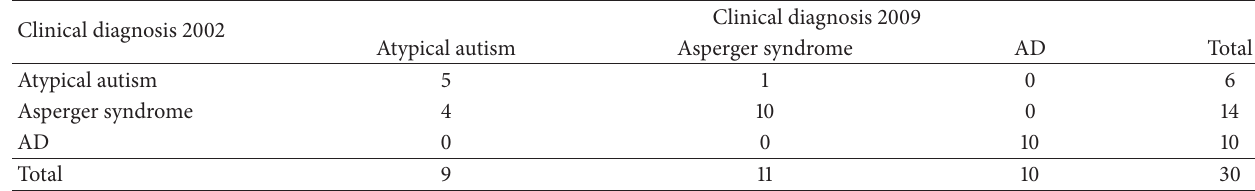
Table 1: Stability of clinical diagnosis from 2002 to 2009 ( 𝑛 = 30